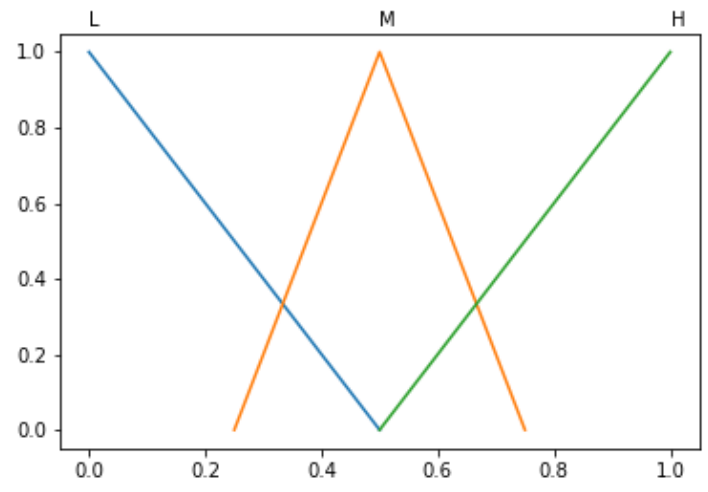
Figure 5. Fuzzy sets for the remaining capacity after visiting customer i .